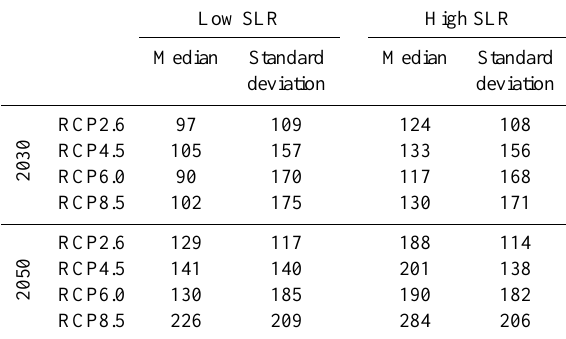
Table 5. Median and standard deviation of flood risk (million USD) between the five GCMs, for each RCP in 2030 and